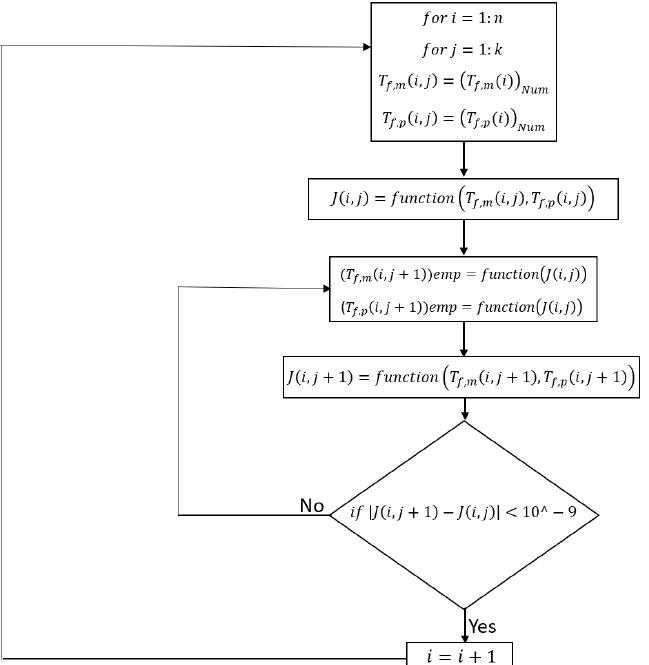
Figure 3. Flowchart illustrating the algorithm developed to include the effect of water